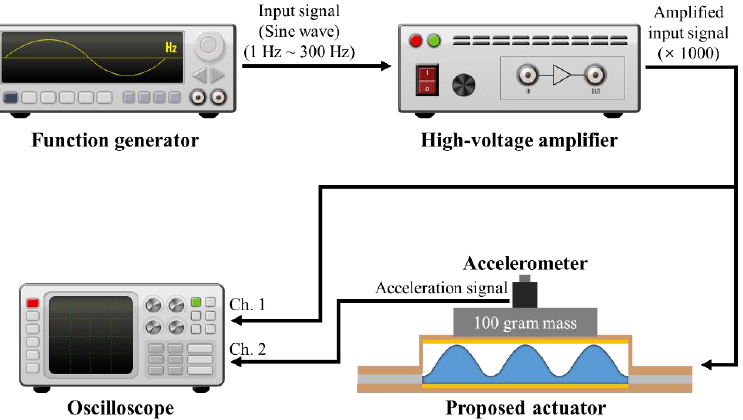
Figure 8. Experimental setup used to investigate the haptic behavior of the proposed actuator.